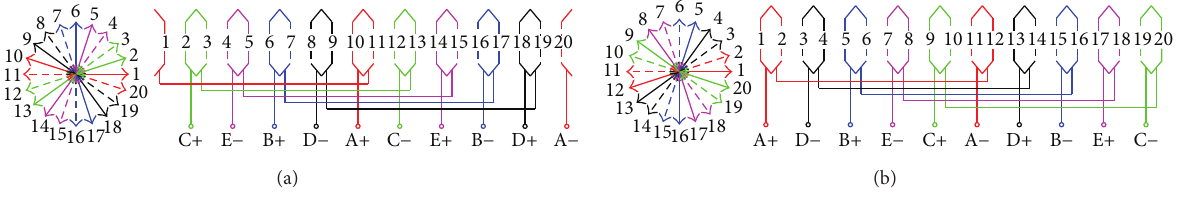
Figure 1: Winding configurations. (a) 𝑝 𝑟 = 9 . (b) 𝑝 𝑟 = 11 .